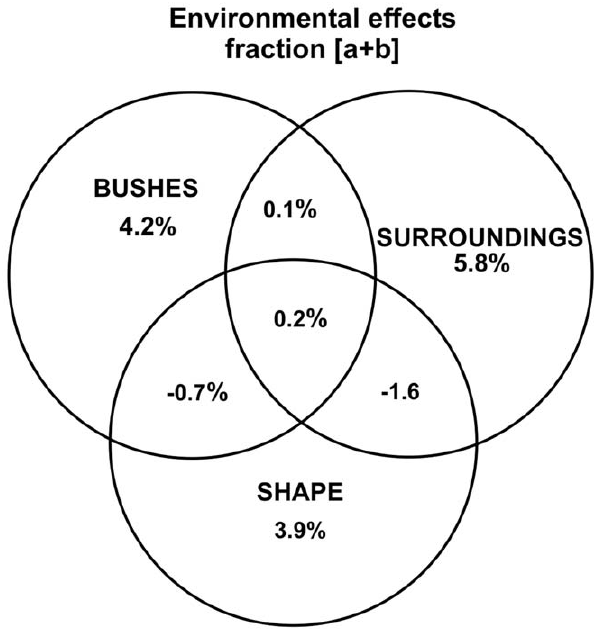
Figure 3. Variation partitioning of environmental variables. Venn diagram showing the results of the variation partitioning procedure carried out on the forward selected environmental variables coupled with a common variation explained by spatial variables (fraction [a + b]).